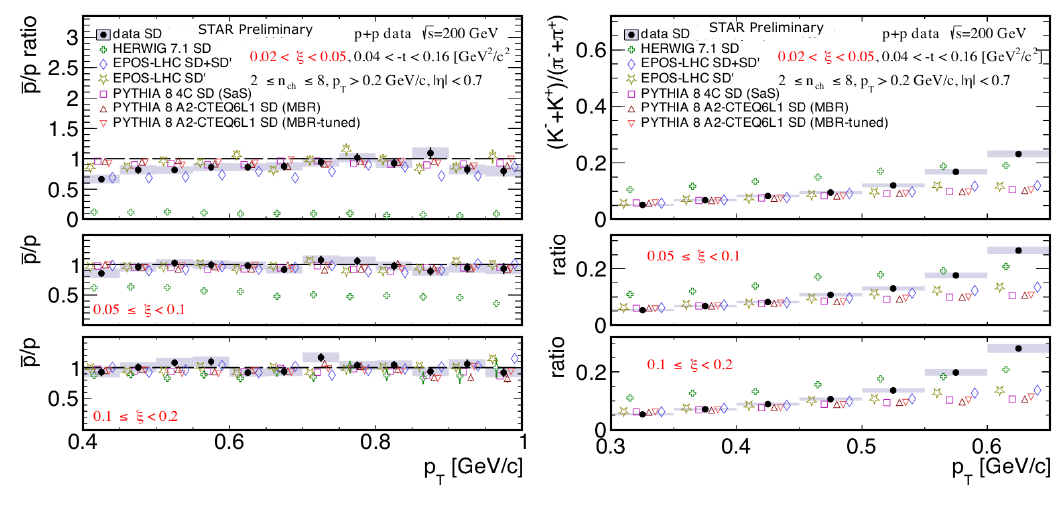
Figure 3: Ratio of production yields of ¯ p / p as a function of p ranges of ξ : (top left) 0.02 < ξ < 0.05, (middle left) 0.05 < ξ < 0.1, (bottom left) 0.1 < ξ < 0.2. Ratio of production yields of tion of p shown in three ranges of ξ : (top right) 0.02 < ξ < 0.05, (middle right) T 0.05 < ξ < 0.1, (bottom right) 0.1 < ξ < 0.2. Data are shown as full dots with error bars representing the statistical uncertainties. Gray boxes represent statistical and systematic uncertainties added in quadrature. Predictions from MC models are shown as open